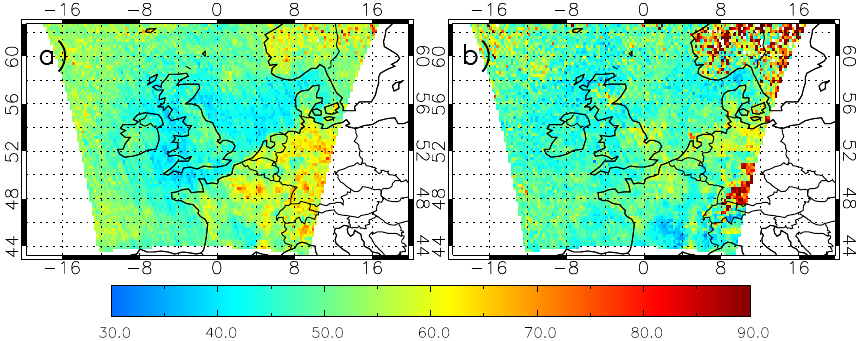
Figure 2. New seasonal satellite mean error, obtained by reduction of random error using the methodology described in Sect. 2, as a percent- age of simple seasonal mean of satellite total error for 2006. Smoothing errors have been removed: (a) summer and (b)